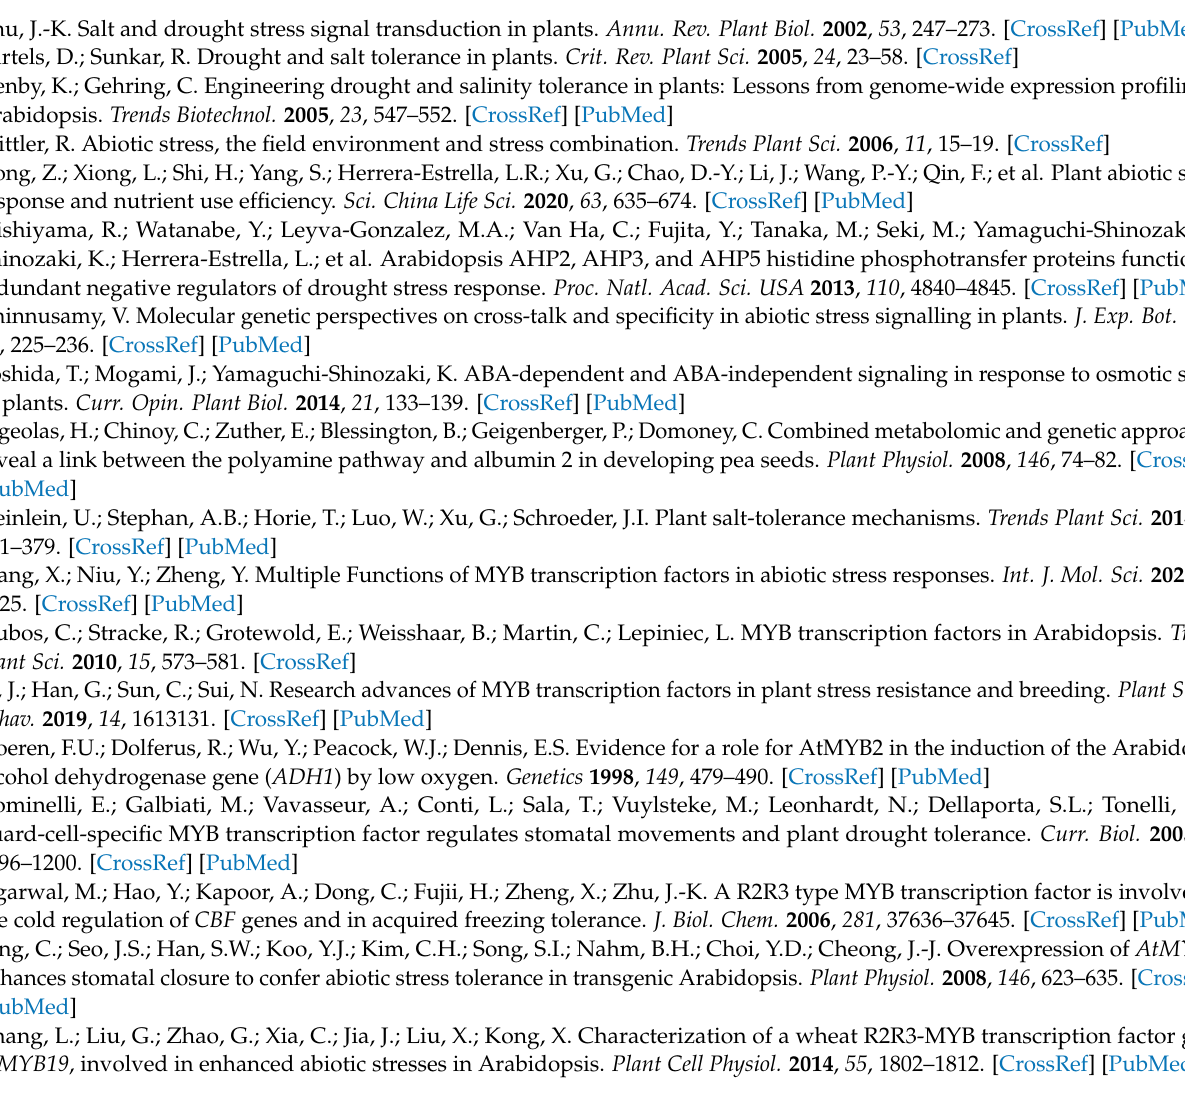
Figure S1: The pCAMBIA1300-IbMYB48-GFP vector used in this